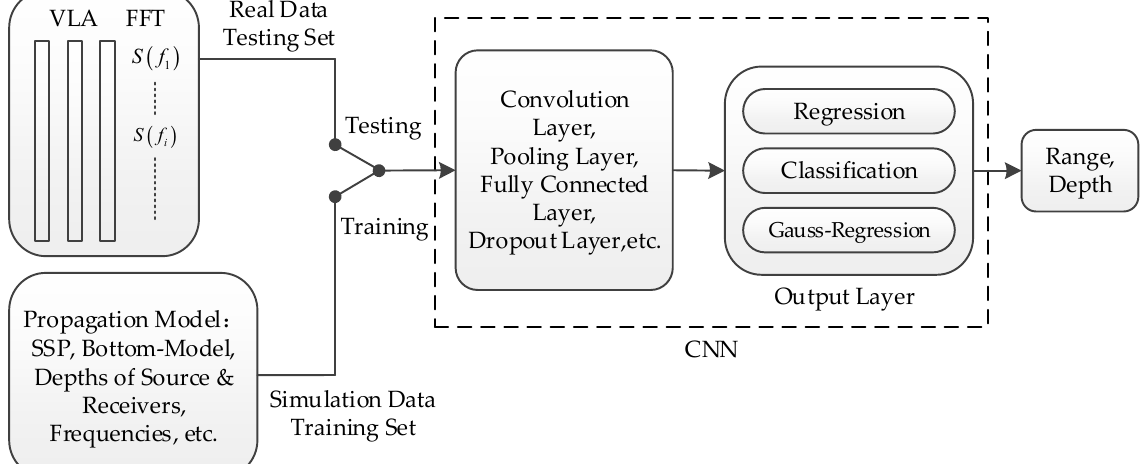
Figure 3. Process diagram of the convolutional neural network (CNN) for processing field sound data received by a vertical array. The real data were set as the test set, and the simulated data were set as the training set. The CNN was trained to output the corresponding Gaussian label of the training set, and the target was then positioned by the trained CNN on the test set to verify the performance of the model.